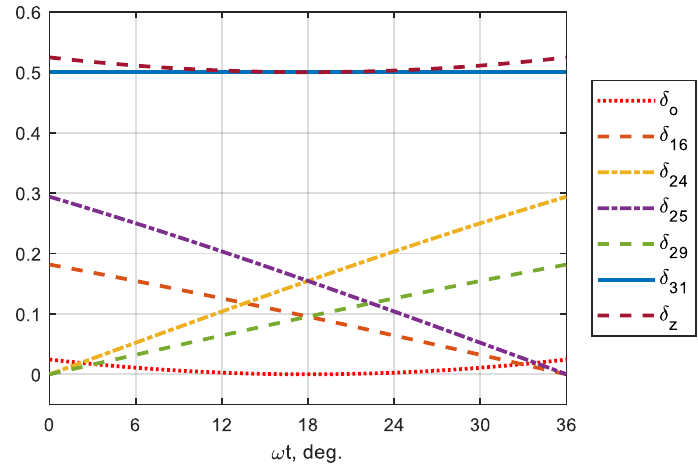
Figure 11. The variation of duty cycles during sector − 1 for M = 0.5.